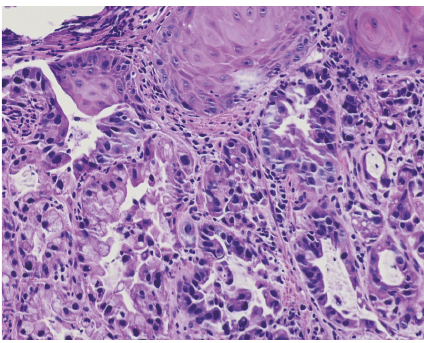
Figure 2: H&E stain of the esophageal tumor showing adenocarci- noma.